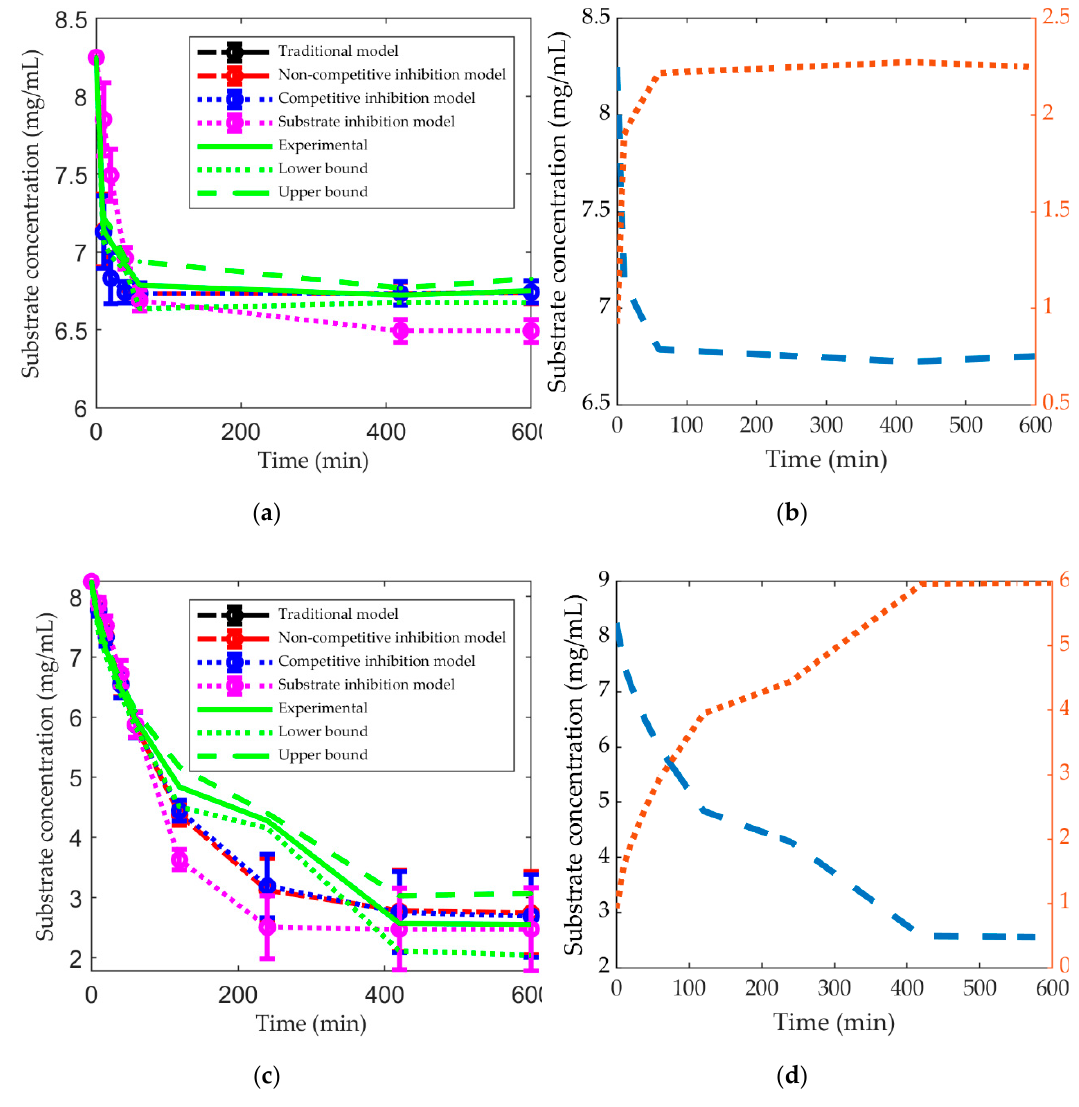
Figure 6. Comparison of the four M–M models calibrated by Interior-Point strategy; ( a ) and ( b ) Experiment 11 @ pH = 5; T = 65 °C; enzyme–substrate ratio = 0.9 μ L of enzyme/g of substrate; ( c ) and ( d ) Experiment 12 @ pH = 5; T = 45 °C; enzyme–substrate ratio = 0.9 μ L of enzyme/g of substrate.